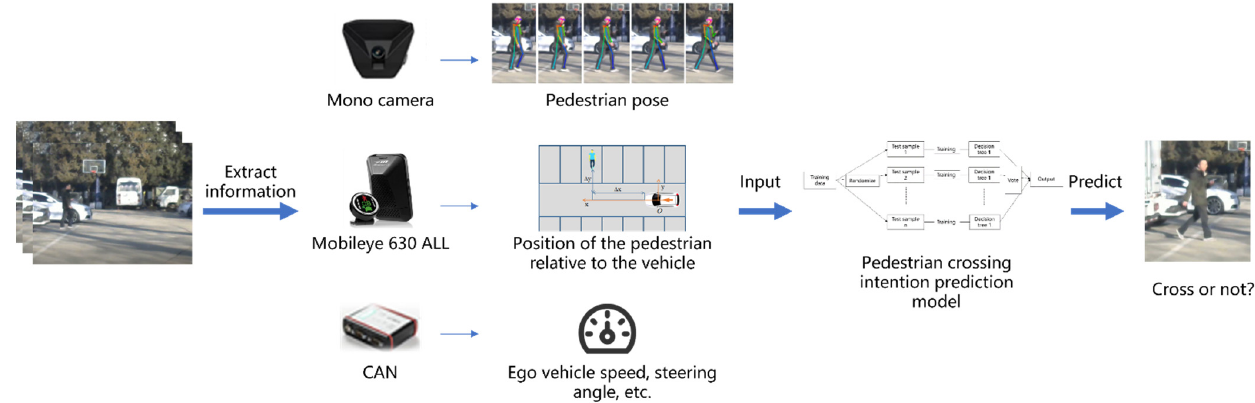
Figure 1. The framework of the proposed model.